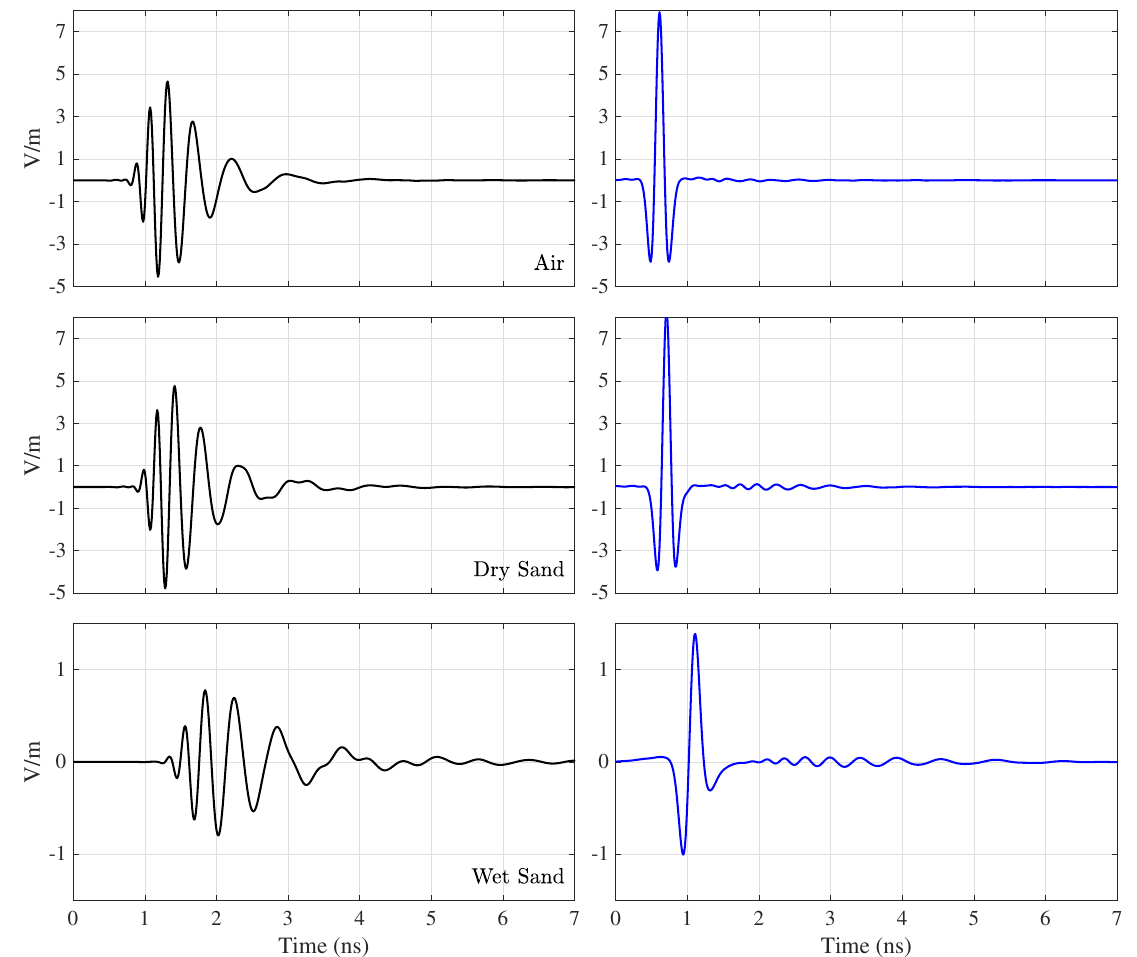
Figure 10. Boresight radiated pulses at 5 cm depth in three different materials: air, dry sand, and wet sand. The pulses are shown both before ( left ) and after ( right ) application of the dispersion model. The wet sand was highly lossy and dispersive, resulting in significantly smaller pulses and less effective pulse correction when using only the simple dispersion model for the